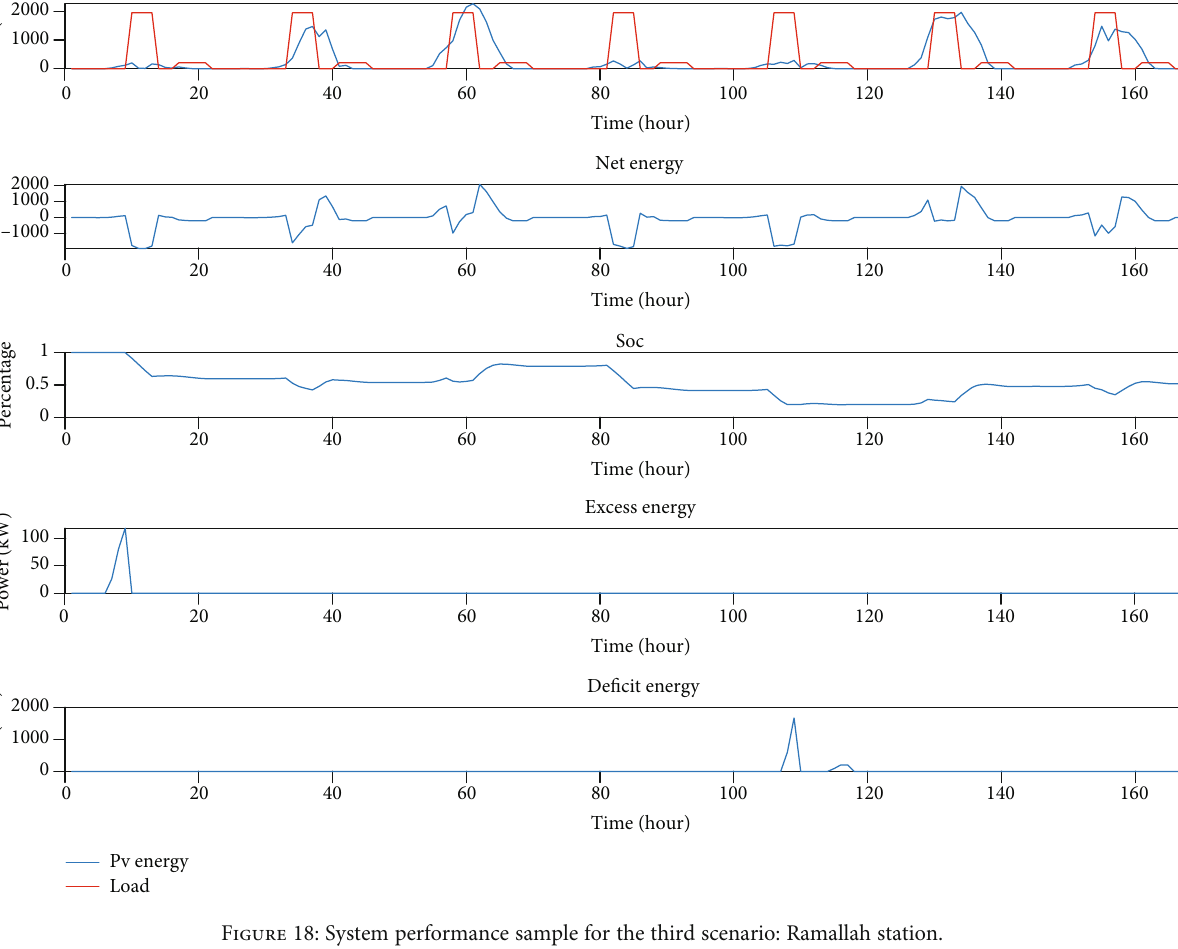
Figure 18: System performance sample for the third scenario: Ramallah station.